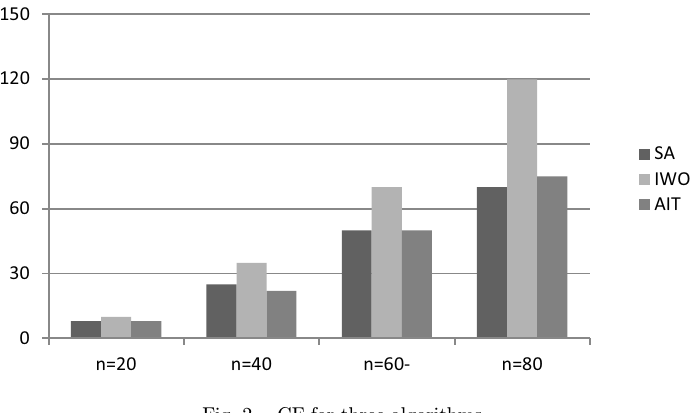
Fig. 2. CF for three algorithms.